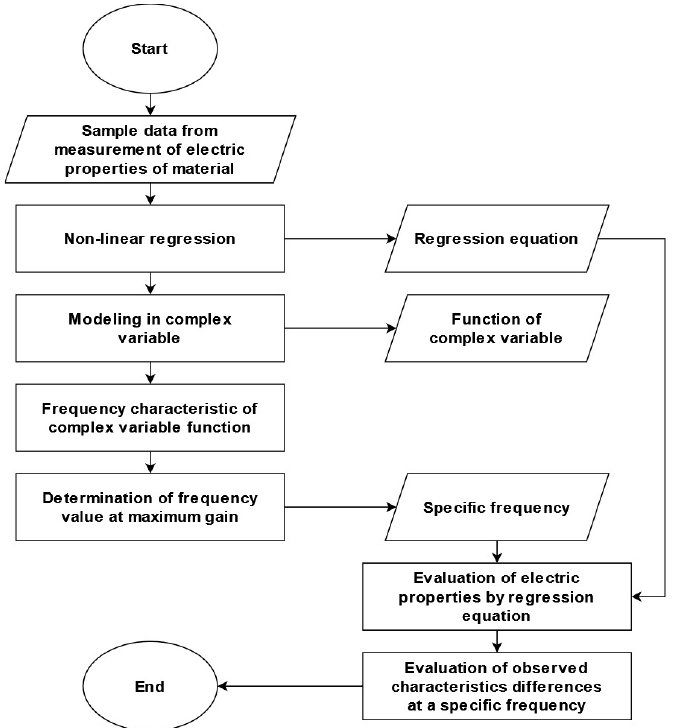
Figure 5. Flowchart for modeling of electrical characteristics, in relation to the value-added foods, in a complex variable.